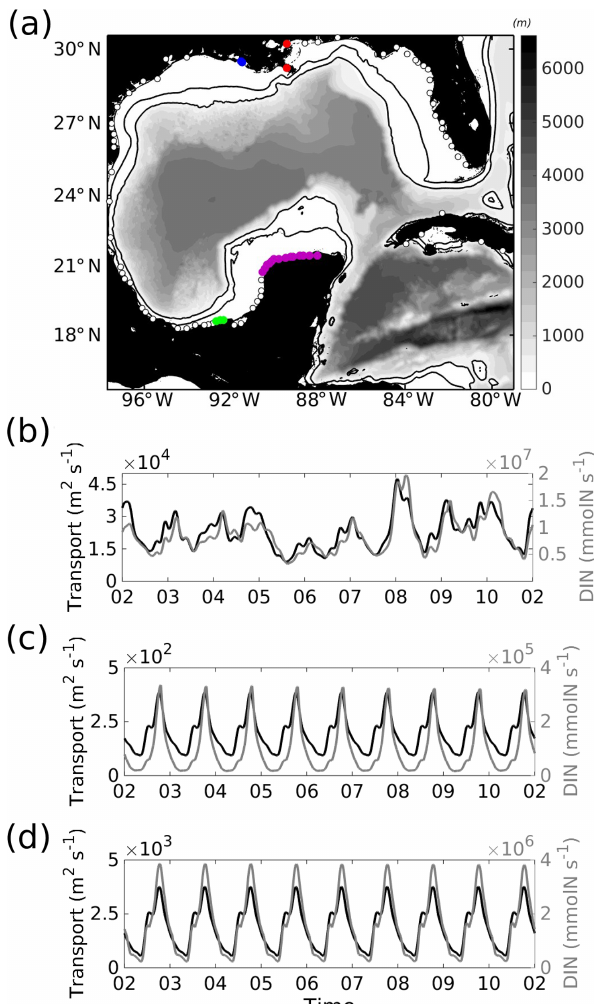
Figure B1. (a) Model bathymetry with the location of the input freshwater sources (white points). Shown as red and blue points is the Mississippi and Atchafalaya riverine system, in green is the Usumacinta and Grijalva riverine system, and in violet is the freshwater system of the YS. The panels below show the tem- poral series of water transport (m 3 s) and the DIN (NO 3 + NH 4 ) fluxes (mmolNs − 1 ) for the systems: (b) Mississippi–Atchafalaya, (c) Usumacinta–Grijalva, and (d) Yucatán shelf